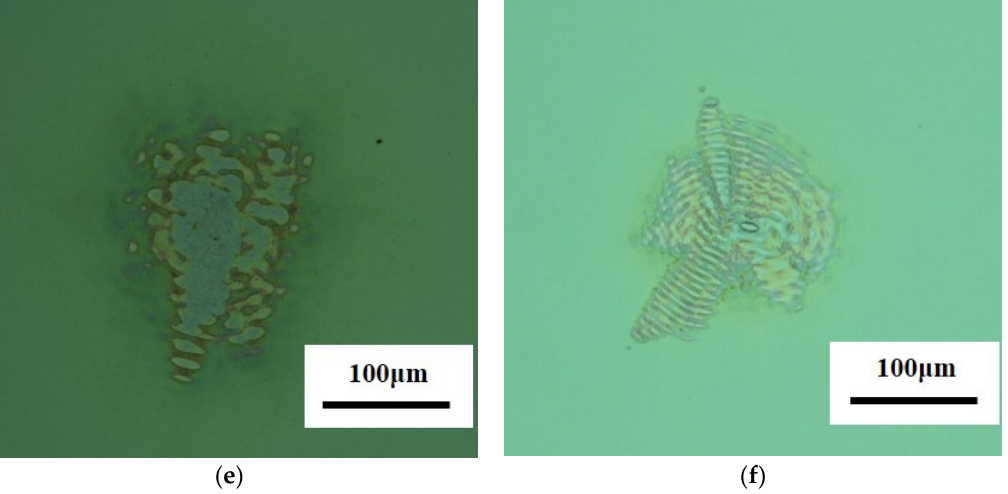
Figure 8. Typical morphologies of laser protection films after laser damage: TiO 2 /SiO 2 film at ( a ) 1064 nm, 5.99 J/cm 2 and ( b ) 532 nm, 3.04 J/cm 2 ;HfO 2 /SiO 2 film at ( c ) 1064 nm, 5.89 J/cm 2 and ( d ) 532 nm, 1.48 J/cm 2 ; Ta 2 O 5 /SiO 2 film at ( e ) 1064 nm, 9.99 J/cm 2 and ( f ) 532 nm, 4.93 J/cm 2 .